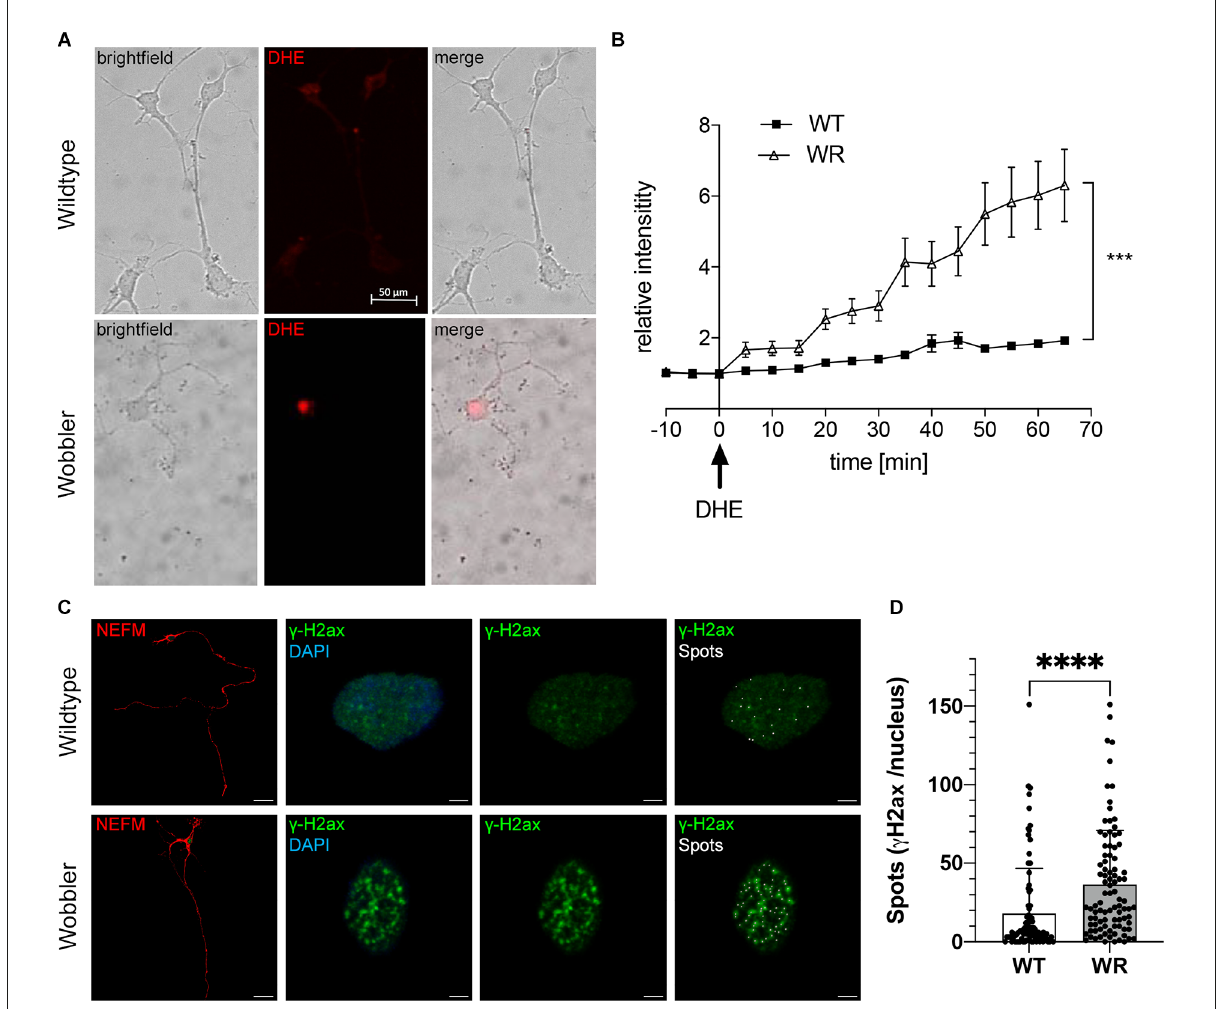
FIGURE2 Elevated ROS levels in motor neurons of Wobbler mice correlate with increased abundance of the DNA damage response protein γ H2ax. (A) Exemplary images of dissociated motor neurons from wild-type and Wobbler animals (p40+10div) 65 min after DHE (red fluorescence) addition and live cell imaging. Live-cell imaging was performed using a spinning disc confocal microscope with a 20 × objective. The fluorescence signals of the cells were documented every 5 min for 1 h in DHE-including medium, 37 ◦ C and 5% CO 2 . Scale bar = 50 µ m. (B) Relative red fluorescence intensity in five dissociated motor neuronal cell cultures from p40 wild-type and Wobbler mice documented in 5 min intervals of 20 cells per genotype. At timepoint 0 the normal medium was exchanged for DHE including medium. ImageJ 1.53f51 (National Institute of Health, USA) was used to analyze the average red fluorescence intensity within the soma of a motor neuron, while motor neurons themselves were detected in transmitted-light channel. A mean value of background fluorescence intensity without DHE addition was used for normalization. Data are provided as means ± SEM. Data were tested for significance using two-way ANOVA with a Sidak post-hoc test. Significant differences are indicated by *** p < 0.001, n = 20 cells from five dissociated cultures per genotype. (C) Exemplary images of wild-type and Wobbler motor neurons (p40+10div) stained with anti-NEFM antibody (red), anti-phospho-Histone H2A.X (green) and DAPI (blue). The overview images (1st row) show an exemplary motor neuron, with rows 2–4 focusing on the nucleus (blue) of the exemplary cell to see the H2ax signals (green) and spots (white) created using Imaris 9.3.1. Pictures were taken with a confocal fluorescent microscope equipped with a 40 × oil objective. Scale bar (1st row) = 30 µ m. Scale bar (2nd–4th raw) = 2 µ m. (D) Detected spots of γ H2ax staining in wild-type and Wobbler motor neuronal cell nuclei. Wobbler mice show a significantly higher number of spots with an average of 36.56 while wild-type motor neurons have an average number of spots of 18.09. Data are provided as means ± SD including individual data points. Data were tested for significance using Student’s t-test. Significant differences are indicated by ∗∗∗∗ p < 0.0001, n = 90–94 nuclei per genotype of a least five